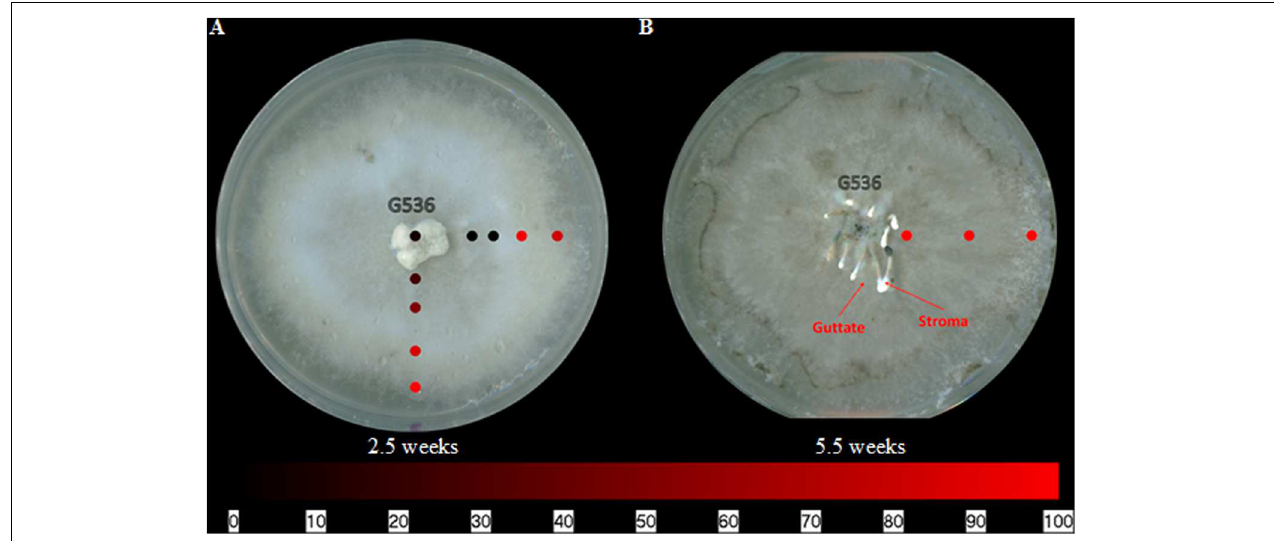
FIGURE 4 | The spatial distribution of griseofulvin on X. cubensis (G536) grown on MEA at (A) 2.5 weeks and (B) 5.5 weeks of growth displaying the locations of guttate and stroma formations. Each circle represents a sampled location. Griseofulvin was most intense where the circles are bright red. The bottom bar indicates the relative amount of signal as measured via mass